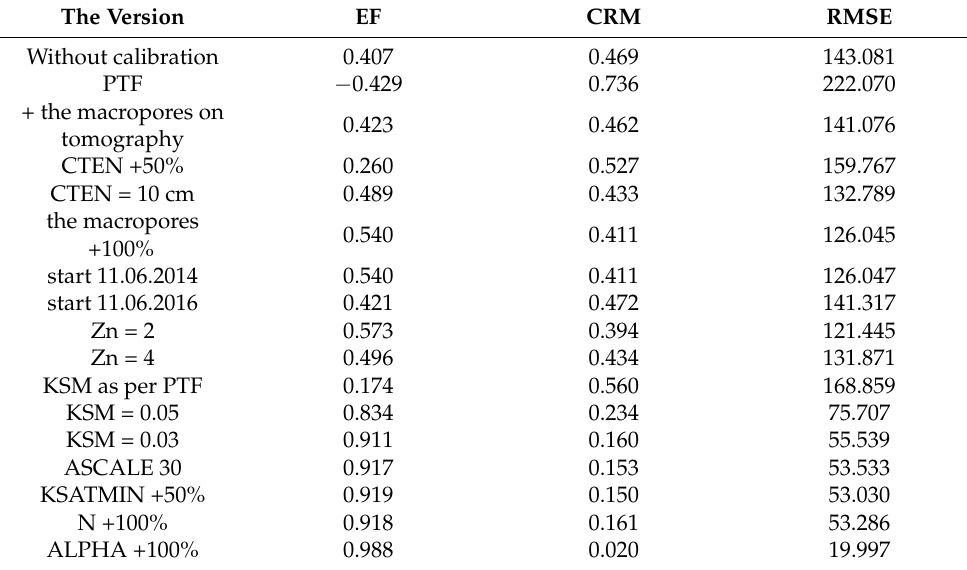
Table 4. Statistic parameters of simulated percolation for uncalibrated and calibrated